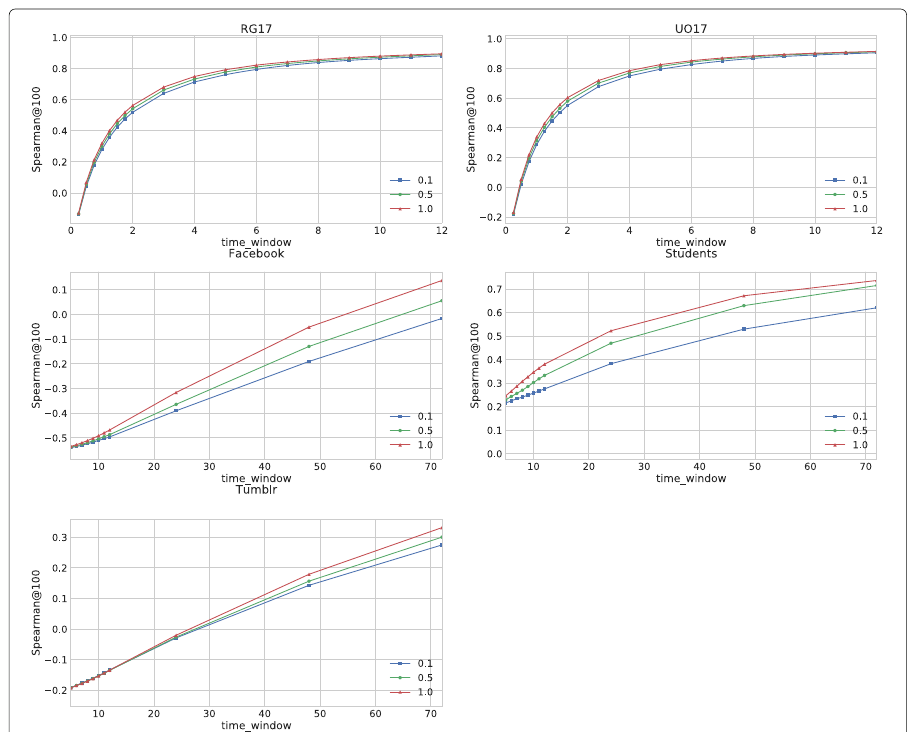
Fig. 8 Average Spearman correlation between temporal Katz centrality scores of adjacent snapshots. Daily snapshots are used for Facebook, Students and Tumblr data sets, and hourly snapshots are used for RG17 and UO17 Twitter collections. The correlation is presented for β values 0.1,0.5,1.0 and several time decay